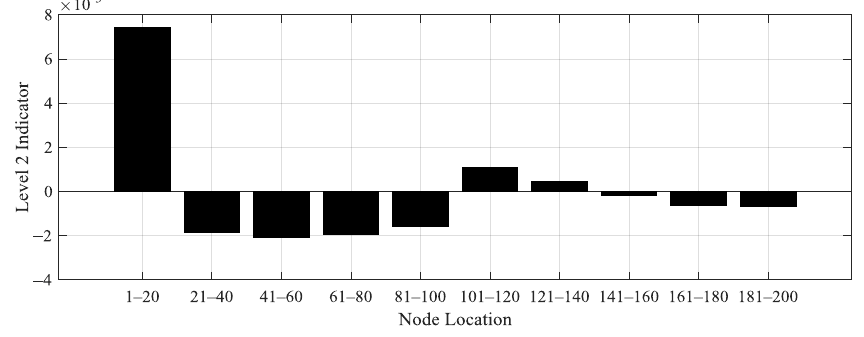
Figure 20. Level 2 damage indicator for Case 1.